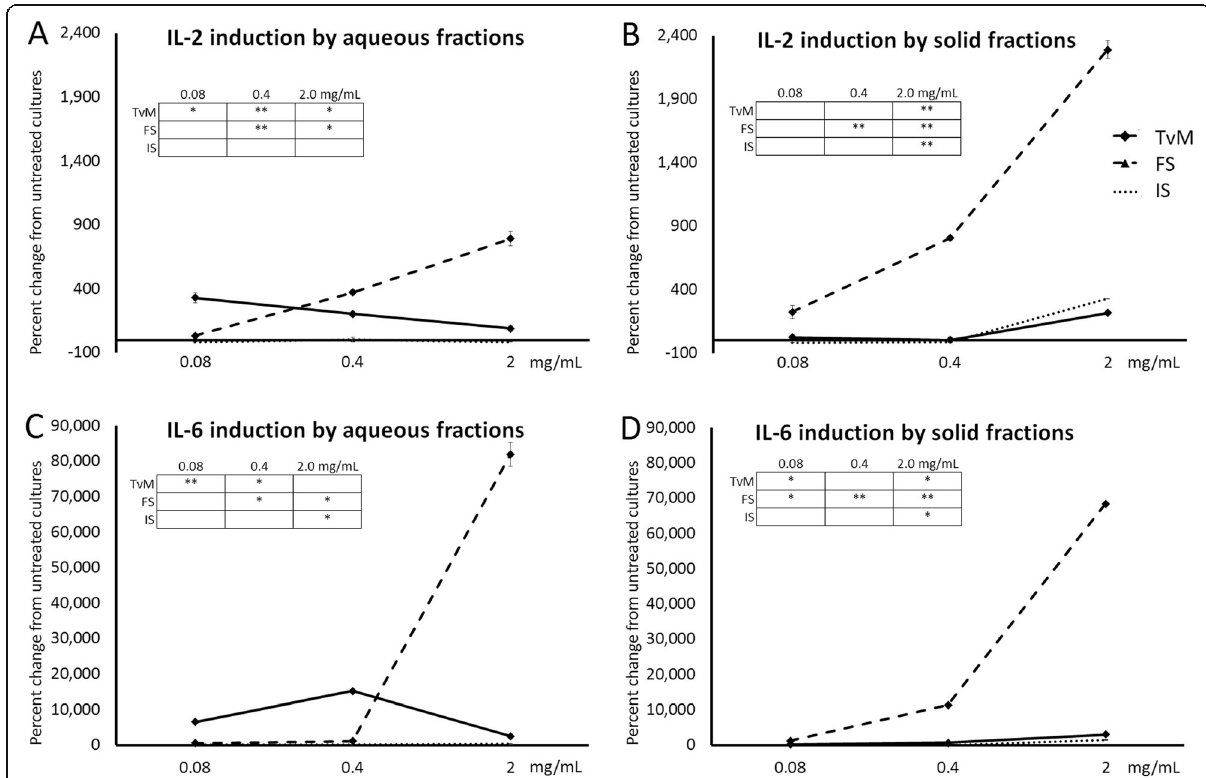
Fig. 5 Changes in levels of the cytokines Interleukin-2 (IL-2) and Interleukin-6 (IL-6) in supernatants from human PBMC cultures. The PBMC were cultured for 24 h in the presence of serial dilutions on Trametes versicolor mycelium (TvM), fermented substrate (FS), or initial substrate (IS). The effects on IL-2 and IL-6, cytokines involved in immune activation, of aqueous extracts shown in a and c , and of the solid fractions are shown in b and d . Data are shown for three doses (0.08, 0.4, and 2mg/mL), where the doses represent the amount of starting material used to produce a given fraction. Data are presented as mean±standard deviation of the percent change seen in triplicate cultures, and represents one of three separate experiments using PBMC cells from three different healthy human donors. Inserted tables: Statistical significance is indicated as * for P<0.05 and ** for